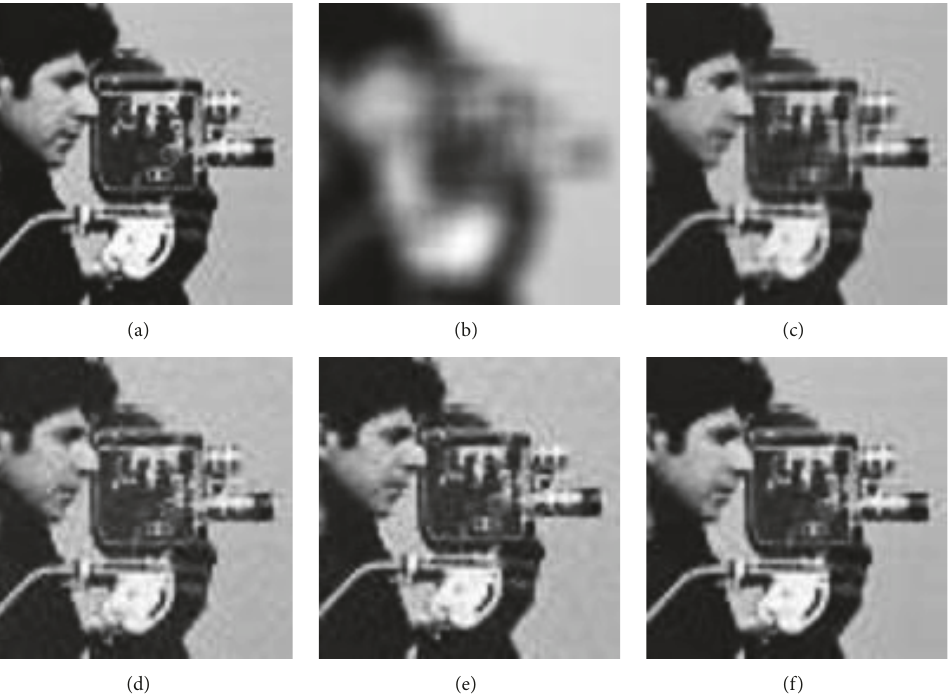
Figure 3: The zoomed regions of the results of Figure 2. (a) Original image; (b) blurred and noisy image; (c) image recovered by FTVd; (d) image recovered by TGV; (e) image recovered by TVframe; (f) image recovered by TGVframe.